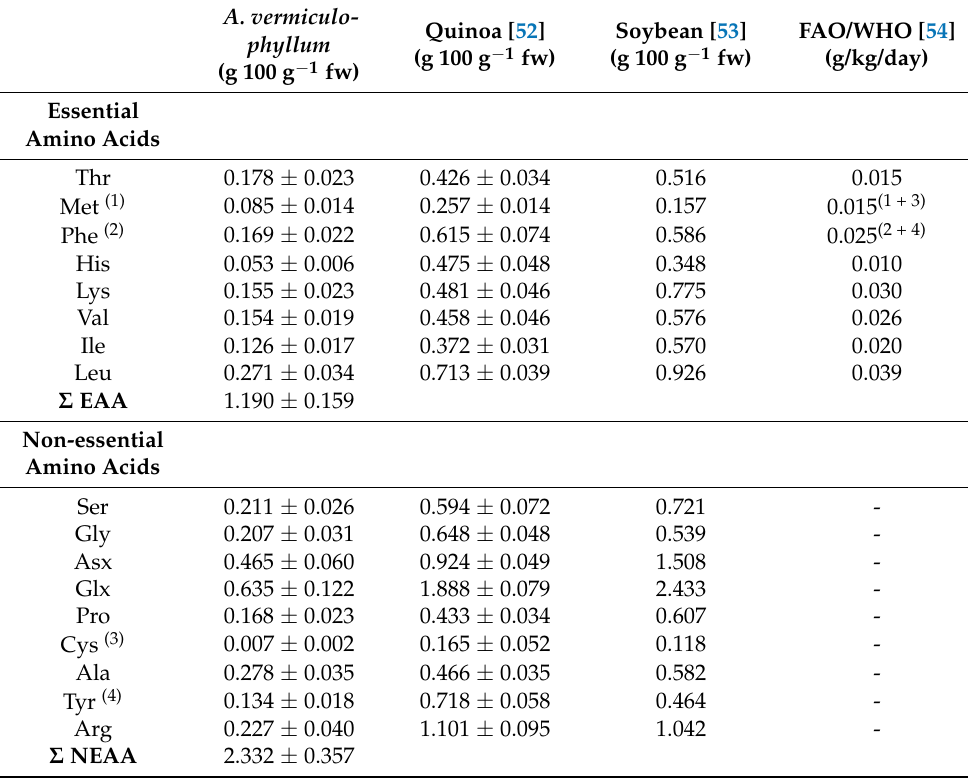
Table 3. Amino acid profile of A. vermiculophyllum compared with raw green soybean, quinoa, and the FAO/WHO requirements in human diet, including essential amino acids (EAA). Data indicates the mean values ± SD. ( n = 6; average of six months, September 2017, October 2017, December 2017, January 18, March 2018 and April 2018). Σ EAA is the sum of all essential amino acids, Σ NEAA is the sum of all non-essential amino acids. Tryptophan was not